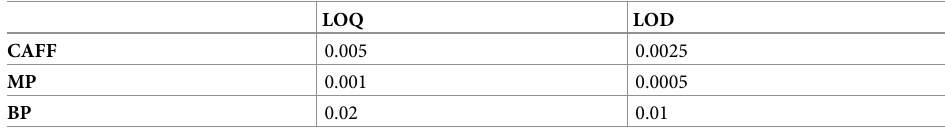
Table 4. Data of LOQ and LOD ( μ g/mL) for CAFF, MP and BP (n = 3). LOQ LOD CAFF